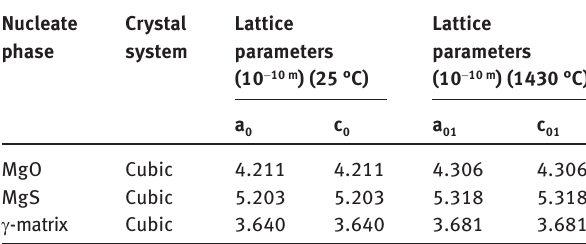
Table 4: Crystallographic date of MgO, MgS and γ -matrix Nucleate phase